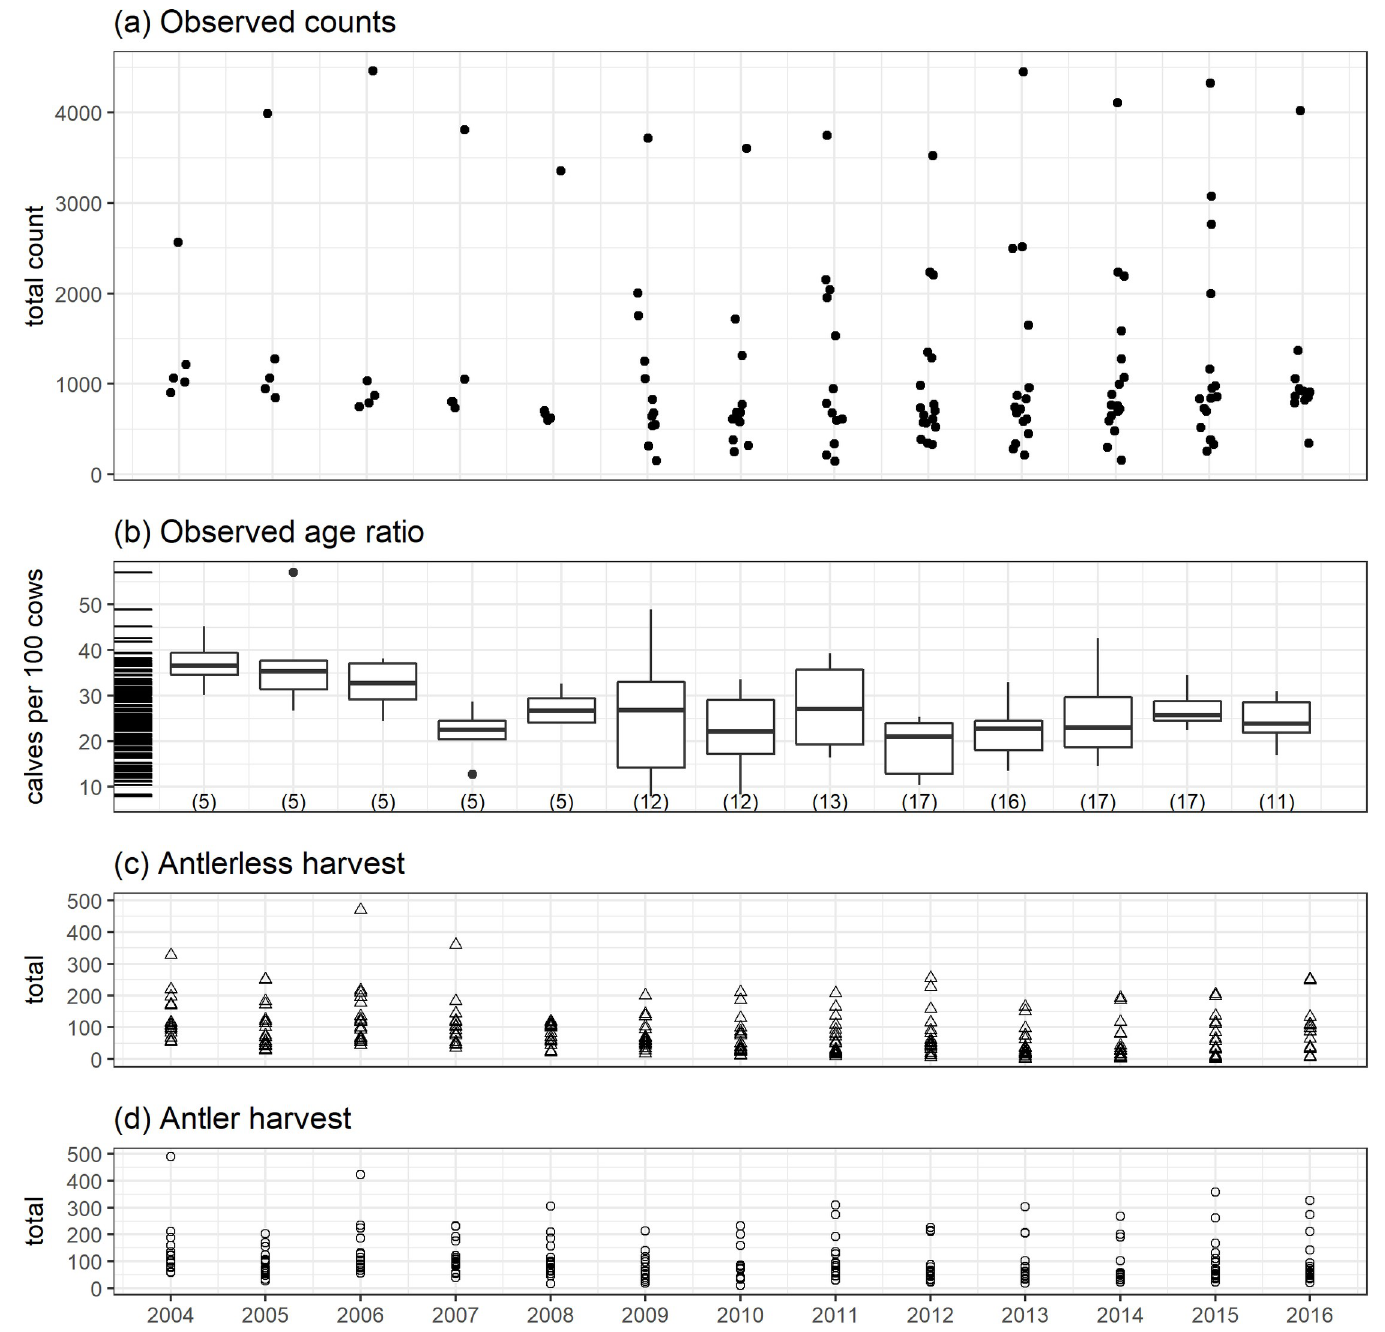
Fig 3. Summary of observed elk count and classification data and estimated antlerless and antlered harvest for the 17 hunting districts included in the elk population model. Both observed counts and age ratios (sample size in parentheses) demonstrated large variation among years and hunting districts. Similarly, antler and antlerless harvest varied through time and district. In panel (a), the observations have been jittered along the x-axis to improve visibility. In panel (b), the y-axis includes a rug that highlights the distribution of the